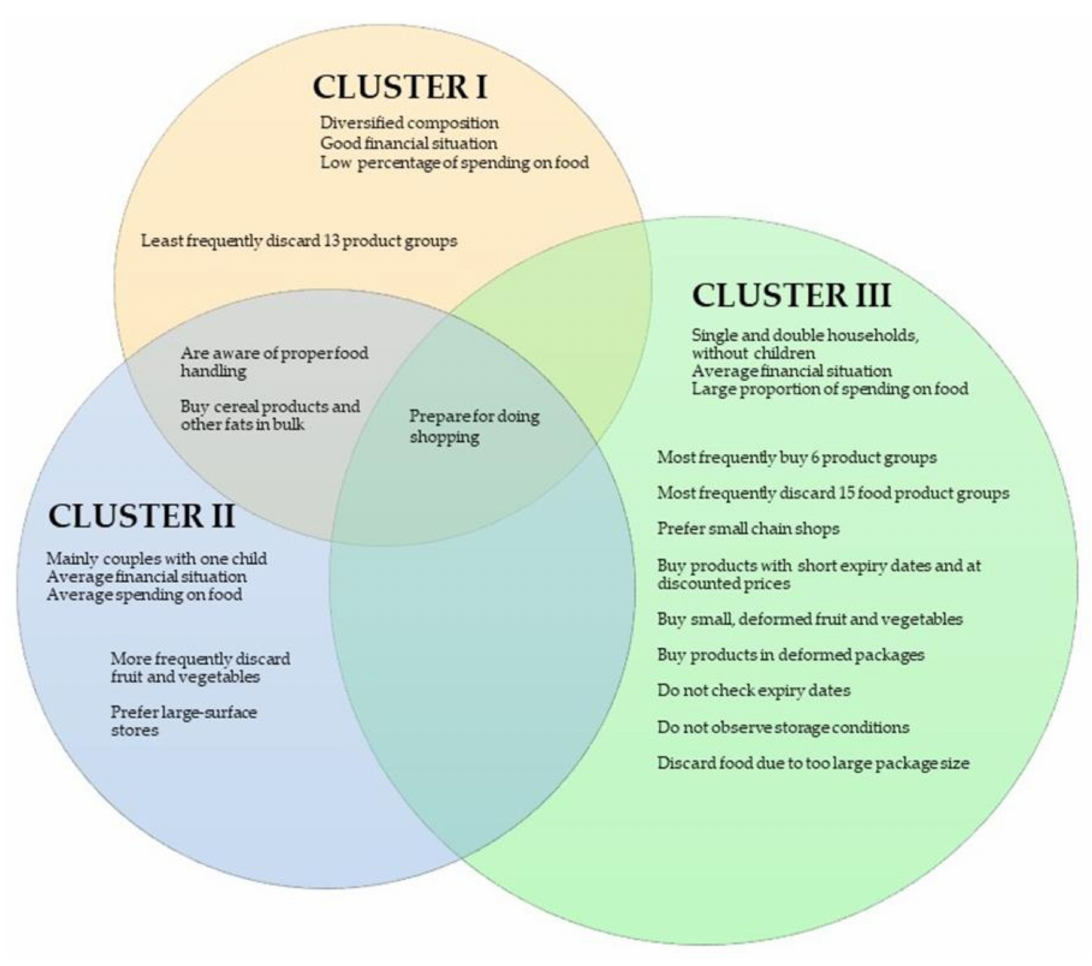
Figure 3. Characteristics di ff erentiating three segments